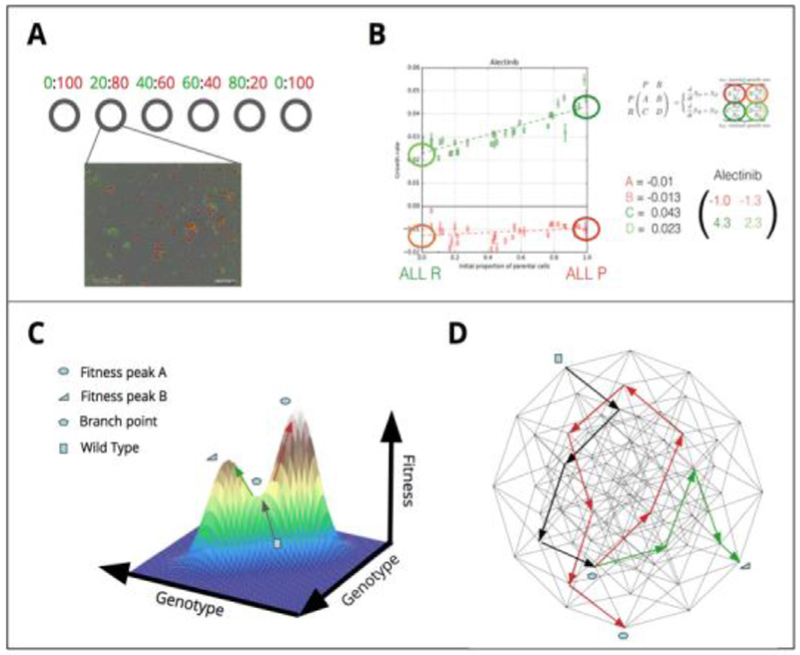
(A) Diagram of experimental setup, with varying proportions up drug sensitive (red) and resistant (green) cells. (B) Parameterization of the two-player game matrix, given the linear relationship between growth rate of drug resistant cells and proportion of seeded sensitive cells. (C) 2D representation of a fitness landscape in which the x-y plane represents genotype, and the landscape height represents fitness. From a single starting point of the wild-type genotype, diverging evolutionary trajectories emerge from saddle points, ending at multiple possible local fitness optima. (D) A six locus landscape drawn as a directed graph, in which each node is a genotype and each edge represents an evolutionary path between them. Arrows illustrate potential paths through multi-dimensional genotype space, toward local fitness optima as shown in panel C.